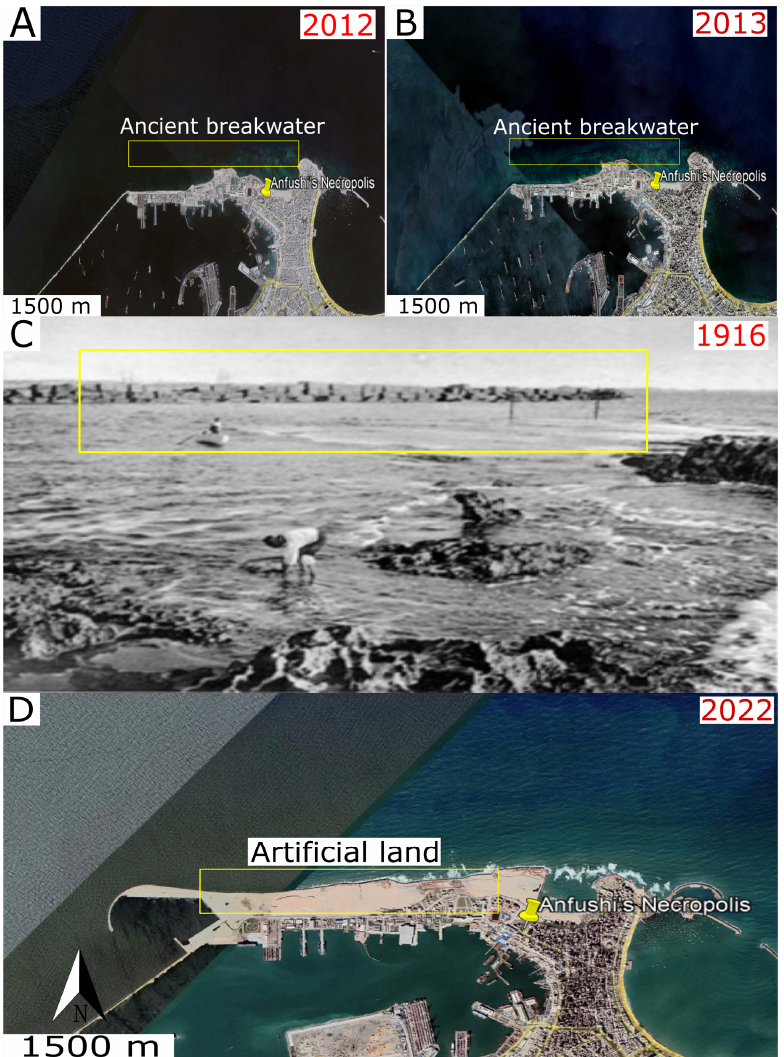
Figure 21. ( A , B ) show two satellite images (2012 and 2013) confirming the submergence of the ancient structures. ( C ) Old photo (1916) of the same area before the submergence of the ancient structures, from [83], and a recent Google Earth image ( D ) for the same area with nourishment